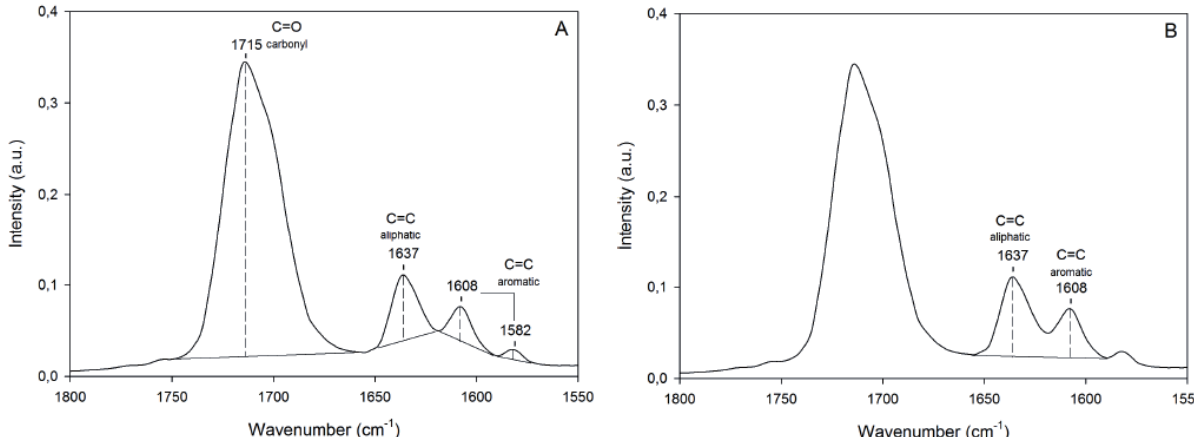
Figure 1 - Schematic representation of the baseline methods proposed to determine the ratios of the absorbance peaks cor- responding to aliphatic (1637 cm − 1 ), aromatic (1608 and 1582 cm − 1 ) or carbonyl (1715 cm − 1 ) bonds. The peak heights were measured in relation to the baseline, determined as follows. ( A ) Baseline was traced by connecting the troughs of each peak. ( B ) Baseline was obtained by connecting the 1637 cm − 1 initial trough and the 1608 cm − 1 final trough.